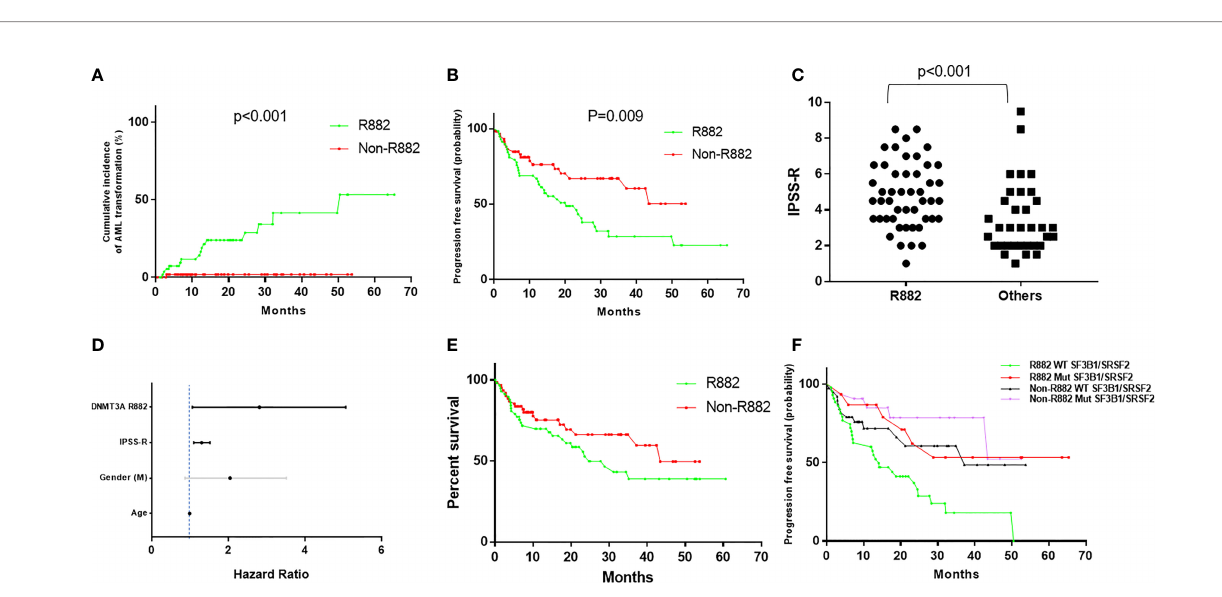
mutationsmayconferhigherriskofdevelopingAMLthannon-R882